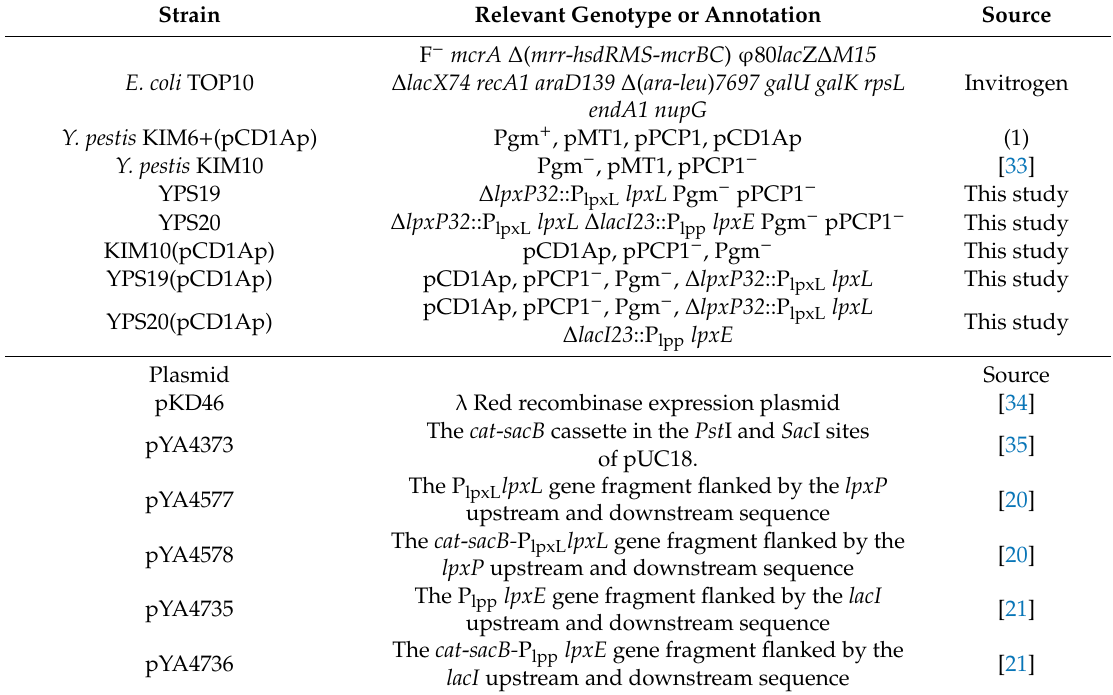
Table 1. Bacterial strains and plasmids used in this